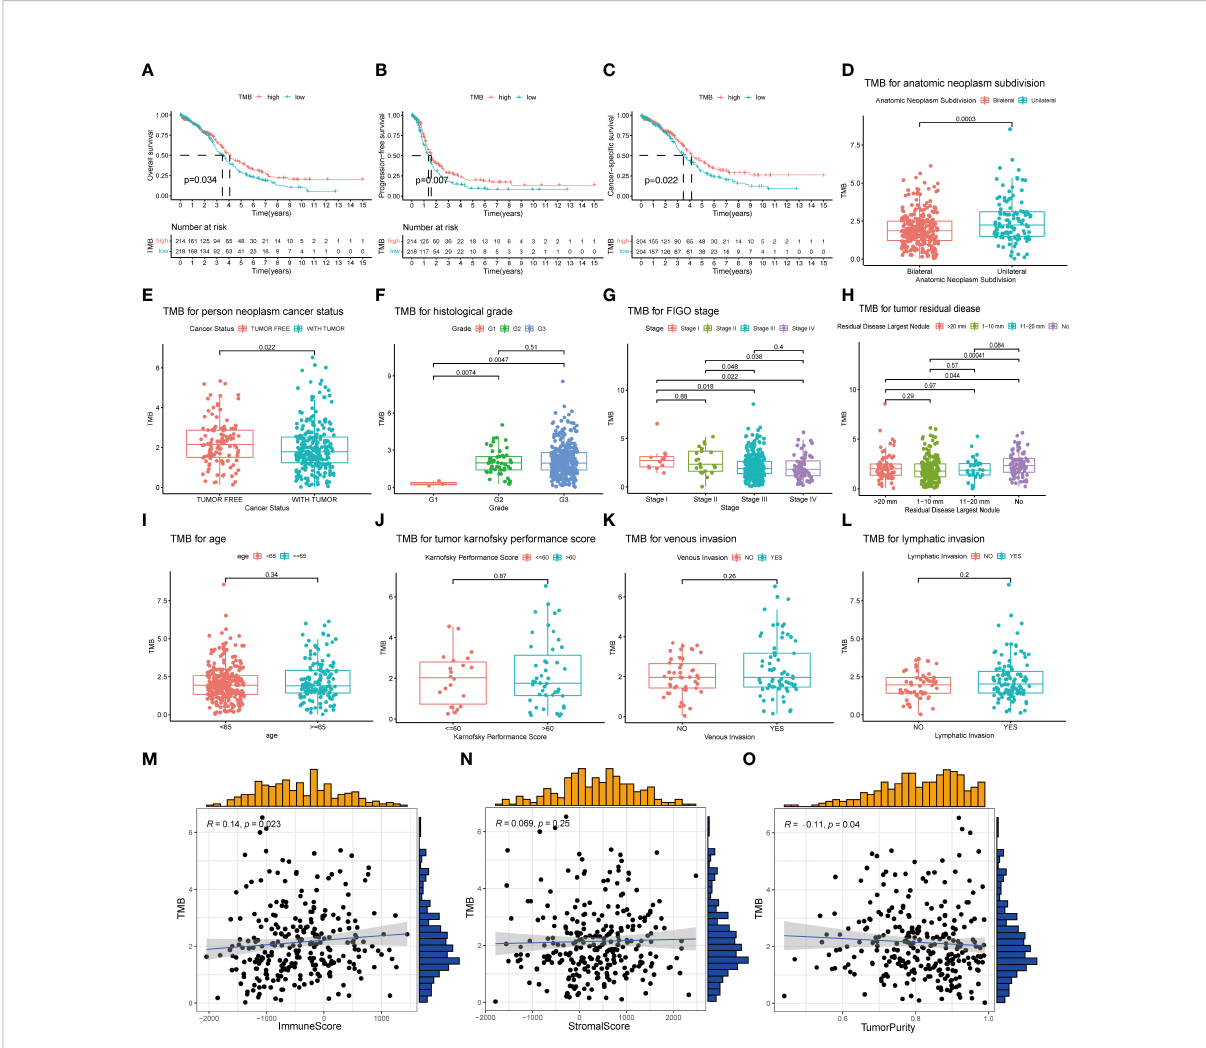
FIGURE 3 Association of TMB with prognosis and clinical traits. (A – C) Lower TMB indicated a better OS, PFS, and CSS with p = 0.034, p = 0.007, and p = 0.022, respectively . (D, E) Unilateral subdivision and tumor-free status correlated with higher TMB level. (F – H) Higher TMB level was associated with higher histological grades, lower FIGO stages, and smaller residual tumor sizes. (I – L) No signi fi cant differences were observed with age, Karnofsky performance score, or venous/lymphatic invasion. (M – O) TMB signi fi cantly correlated with immune scores and tumor purity but not with stromal scores. TMB, tumor mutational burden; OS, overall survival; PFS, progression-free survival; CSS, cancer-speci fi c survival; FIGO, International Federation of Gynecology and